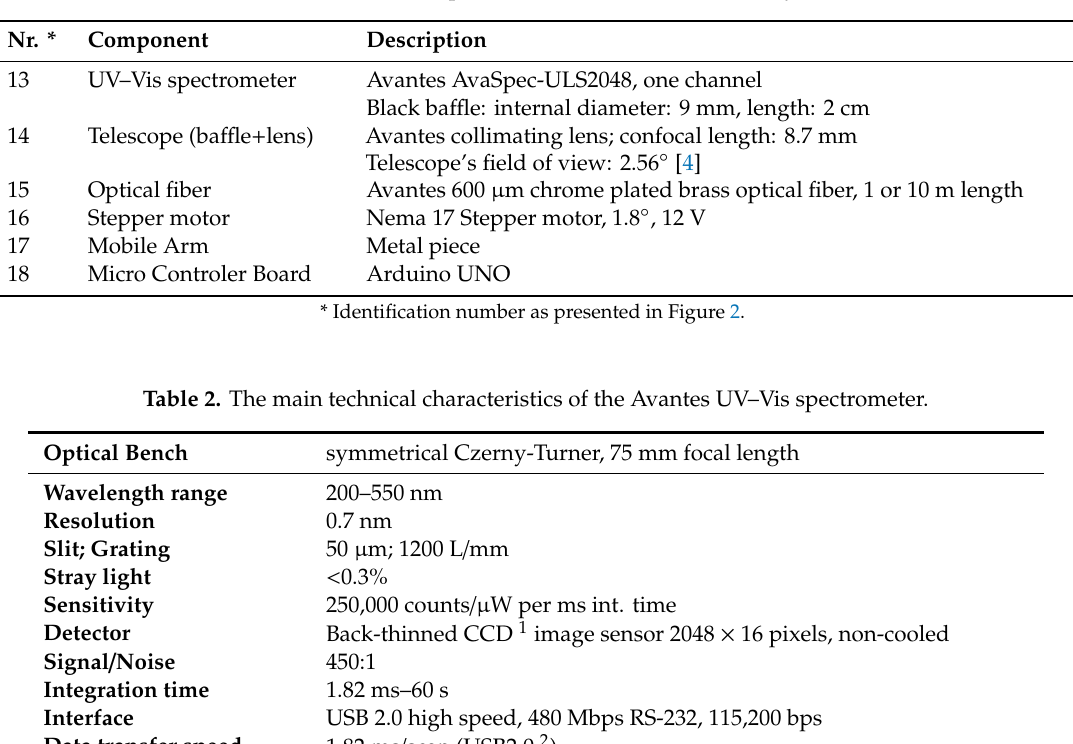
Table 1. The main components of the UGAL-2D-DOAS system.